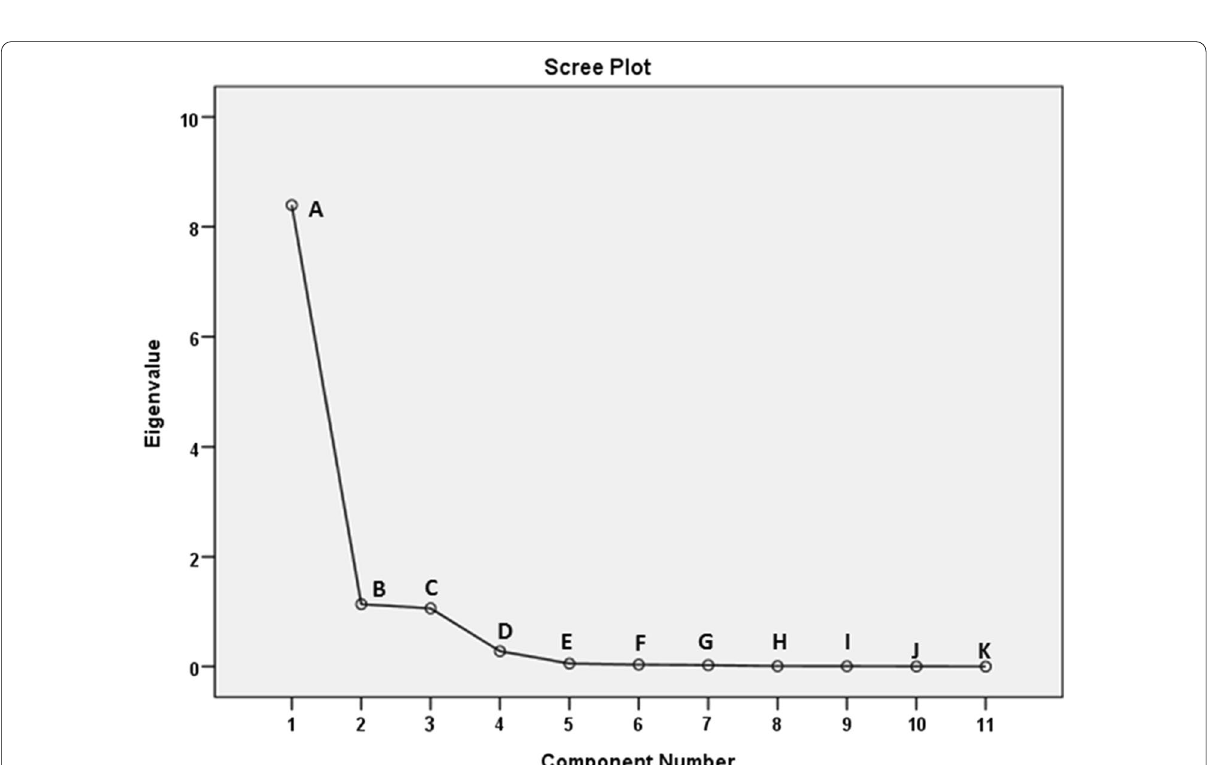
Fig. 3 The scree plot of eigenvalue for the component number of disease parameters, plant growth parameters and yield components in response to sunflower powdery mildew in the pooled data of 2019 and 2020 seasons. Details—A: FDS (%), B: AUDPC, C: efficacy %, D: chlorophyll (µg/cm2), E: plant height, F: head diameter, G: stem girth, H: number of leaves, I: seed yield (kg/fed), J: oil content (%) and K: 1000‑seed weight